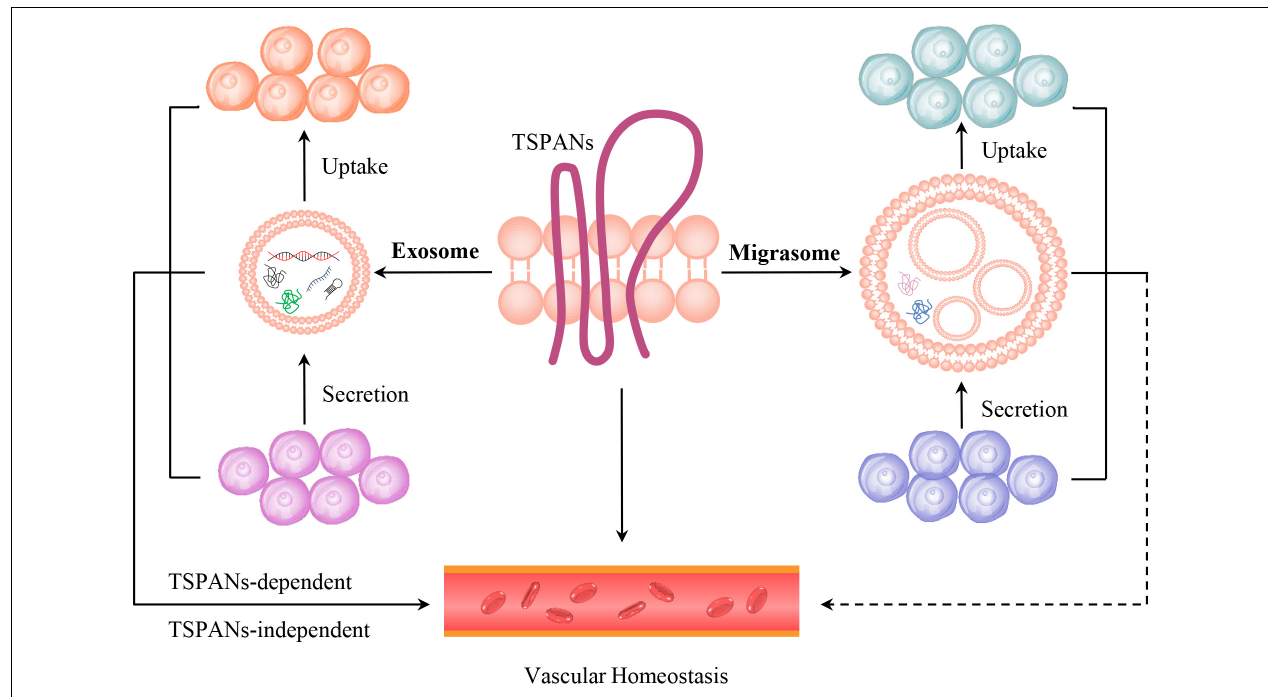
FIGURE 2 | The models of TSPANs, exosomes and migrasomes in vascular homeostasis. TSPANs are the key organizators of both exosome and migrasome. TSPANs can regulate vascualr homeostasis directly. Exosomes, which contain selected proteins, lipids, nucleic acids, amino acids, glycoconjugates and metabolites et al., are secreted by one cell and taken up by another cell, thus transferring signals through cell–cell communication and influencing vascular homeostasis in TSPANs-dependent or independent manners. Migrasomes, which are distributed in blood circulation and blood vessel, contain bioactive cargos, and are also secreted by one cell and taken up by the surrounding cells. Therefore, migrasomes might influence vascular homeostasis via cell–cell communication.